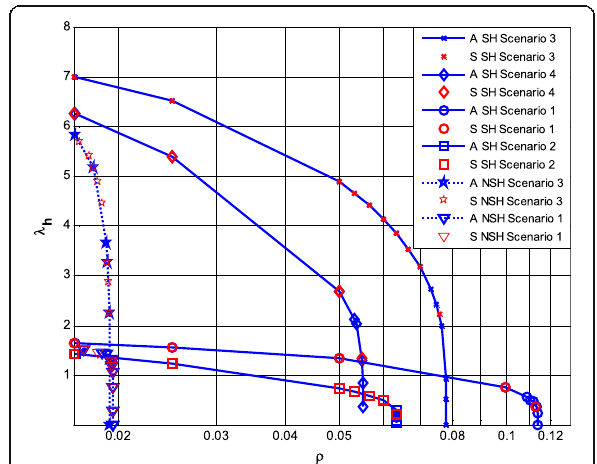
Fig. 10 Inter-cell handoff arrival rate for the Erlang capacity is shown in Fig. 8, as a function of the utilization factor of the primary channels for the scenarios described in Table 6. Both spectrum handoff and non-spectrum handoff are considered for scenarios 1 and